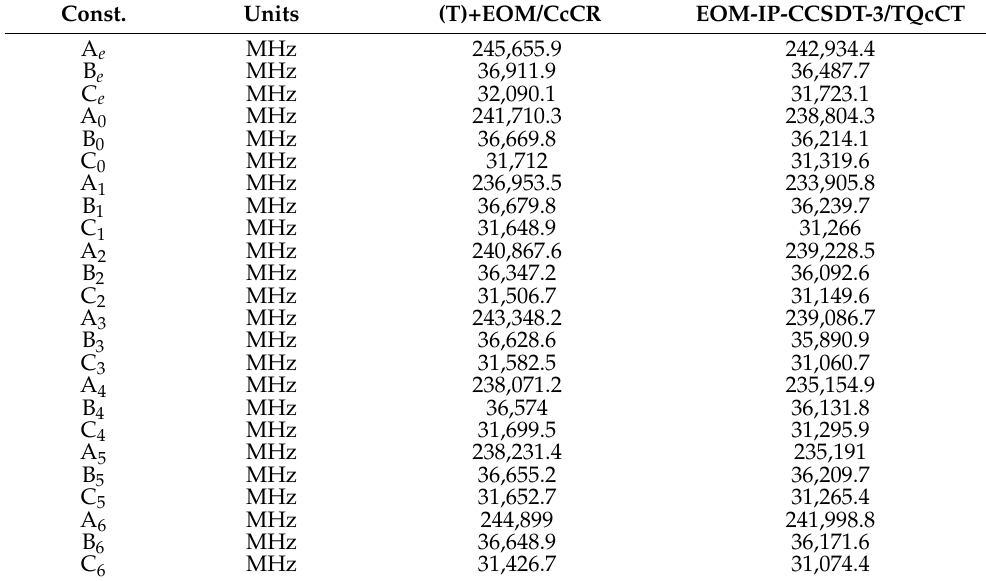
Table A9. ˜B 2 A 1 H 2 CO + Rotational Constants MHz.